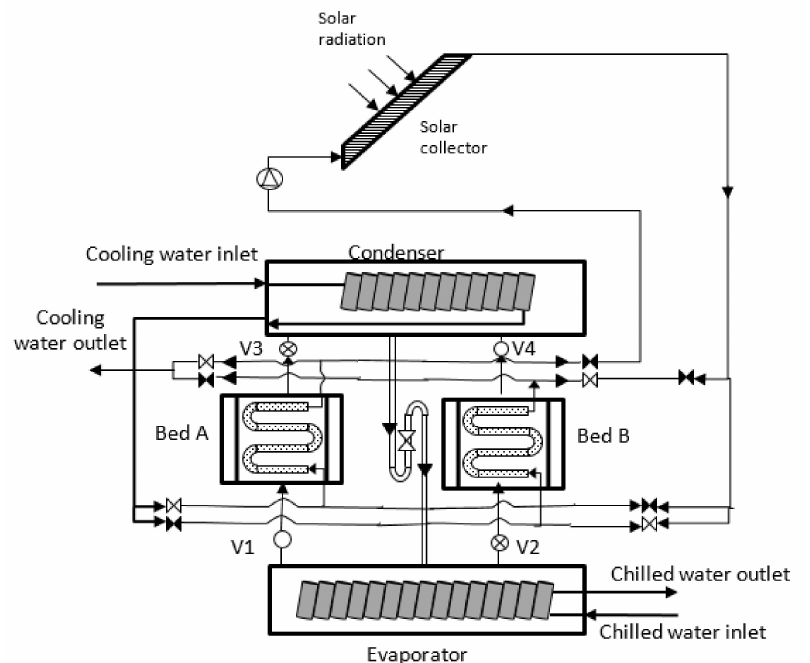
Figure 1. A schematic drawing of an adsorption cooling chiller driven by the compound parabolic collector (CPC) solar collector